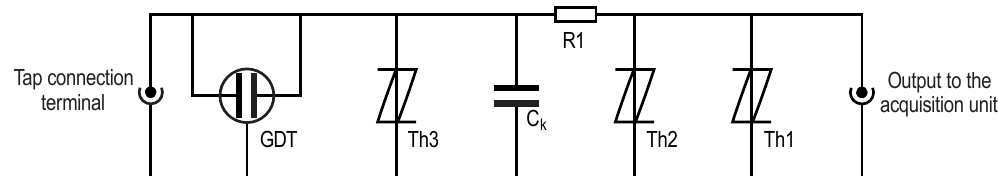
Figure 6. Circuit implemented in the printed circuit board (PCB) for the acquisition of partial discharges (PDs) and protection against surges.